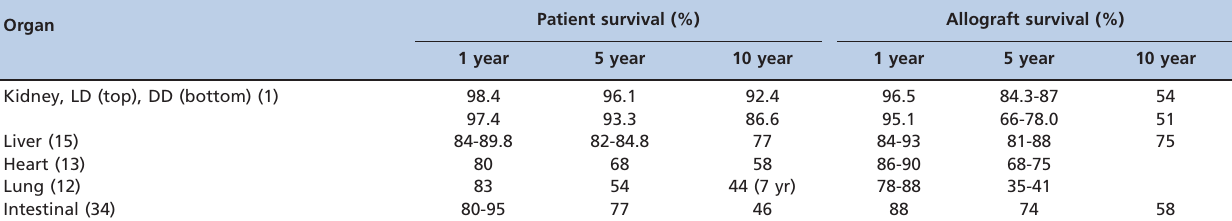
Table 1 - Patient and allograft survival of children after kidney, liver, heart, lung and intestinal transplantation. Living Donor, Deceased